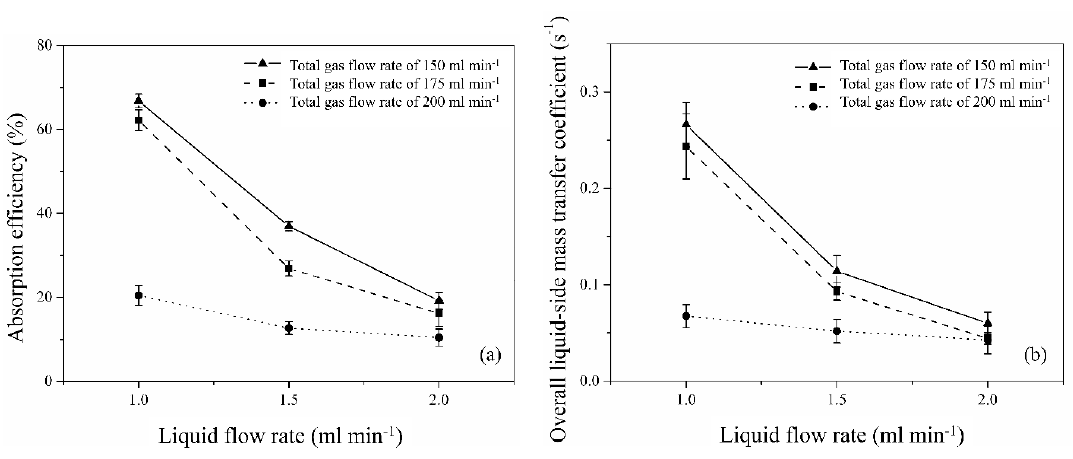
Figure 3. Effects of total flow rate of gas and liquid on the responses: ( a ) absorption efficiency, ( b ) Figure 3. E ff ects of total flow rate of gas and liquid on the responses: ( a ) absorption e ffi ciency, overall liquid-side mass transfer coefficient. ( b ) overall liquid-side mass transfer coe ffi